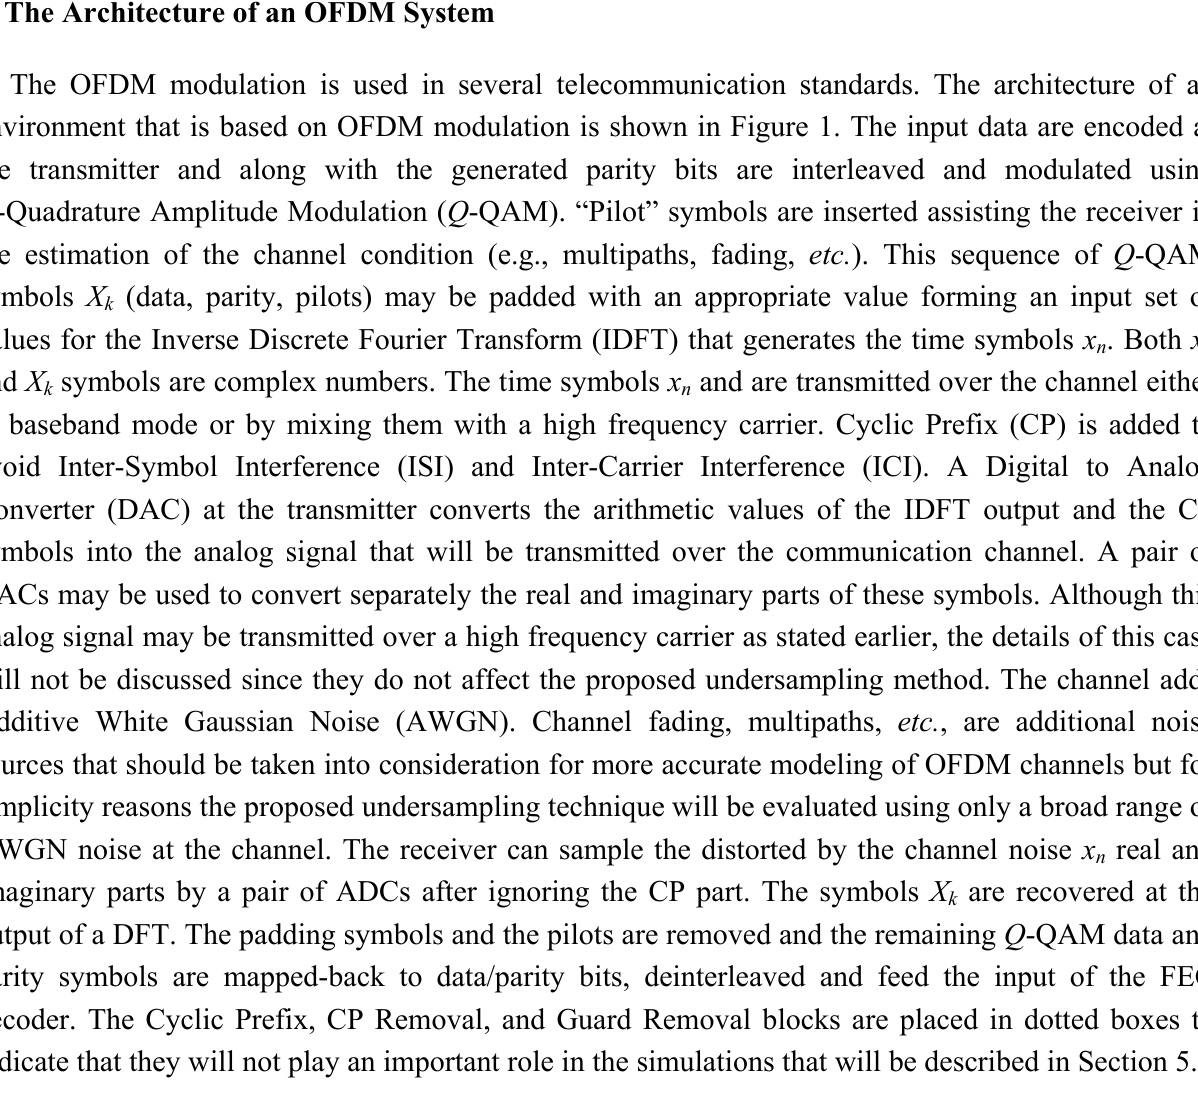
Figure 1. Architecture of an OFDM